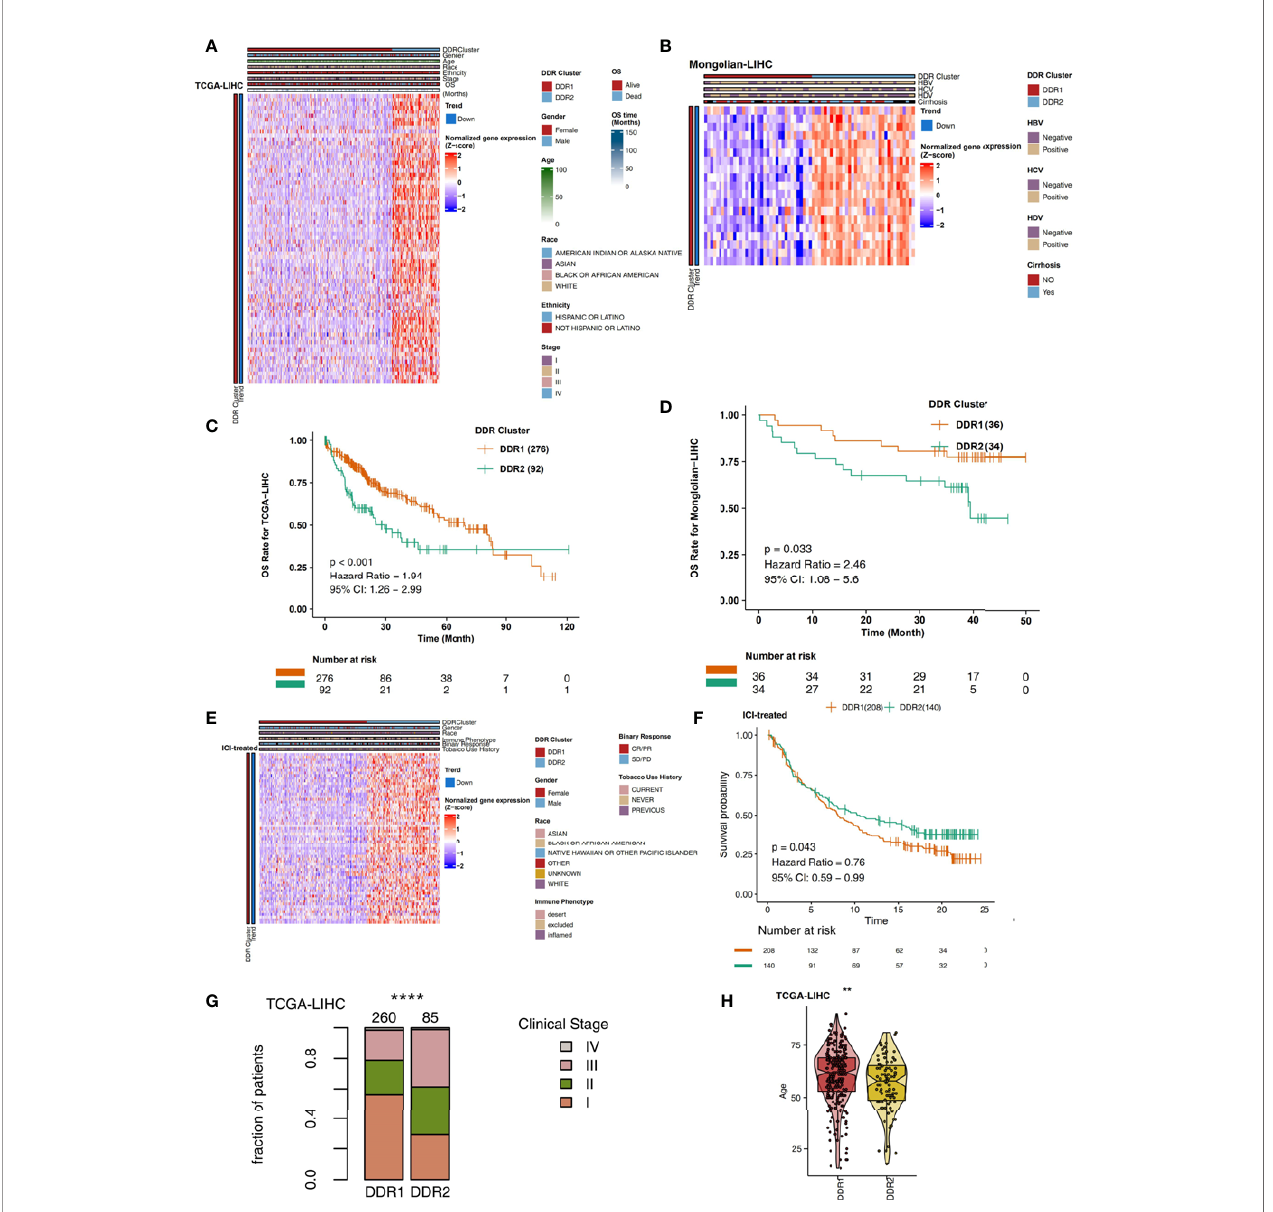
FIGURE 2 | (A) Heatmap showing normalized expression levels of DDR-related signature genes (rows) across subjects (columns) classi fi ed into two molecular subclasses, DDR1 and DDR2, which were determined by an unsupervised approach (consensus clustering), in the TCGA-LIHC cohort. Each signature gene is signi fi cantly upregulated or downregulated in one subclass relative to the other subclasses, as indicated by the annotation bars on the left side. Clinical annotations are shown at the top. (B) Overall survival for subjects grouped according to molecular subclass (DDR1 and DDR2) in the TCGA-LIHC cohort. (C) Heatmap showing normalized expression levels of DDR-related signature genes (rows) across subjects (columns) classi fi ed into two molecular subclasses (DDR1 and DDR2), which were determined by an unsupervised approach (consensus clustering), in the Mongolian-LIHC cohort. Each signature gene is signi fi cantly upregulated or downregulated in one subclass relative to the other subclasses, as indicated by the annotation bars on the left side. Clinical annotations are shown at the top. (D) Overall survival for subjects grouped according to molecular subclass (DDR1 and DDR2) in the Mongolian-LIHC cohort. (E) Heatmap showing normalized expression levels of DDR-related signature genes (rows) across subjects (columns) classi fi ed into two molecular subclasses (DDR1 and DDR2), which were determined by an unsupervised approach (consensus clustering), in the ICI-treated BLCA cohort. Each signature gene is signi fi cantly upregulated or downregulated in one subclass relative to the other subclasses, as indicated by the annotation bars on the left side. Clinical annotations are shown at the top. (F) Overall survival for subjects grouped according to molecular subclass (DDR1 and DDR2) in the ICI-treated cohort. (G) Comparison of the proportions of patients in different clinical stages between two molecular subclasses (DDR1 and DDR2) in the TCGA-LIHC cohort. (H) Comparison of age between two molecular subclasses (DDR1 and DDR2) in the TCGA-LIHC cohort (**P < 0.01; ****P <